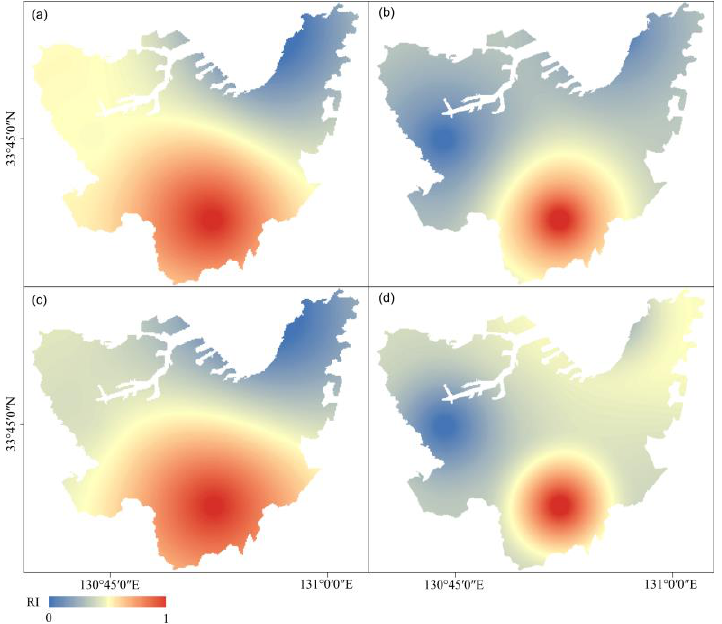
Figure 10. Rainfall impact (RI) maps of ( a ) development stage; ( b ) peak stage; ( c ) stagnation stage; and ( d ) decline stage.